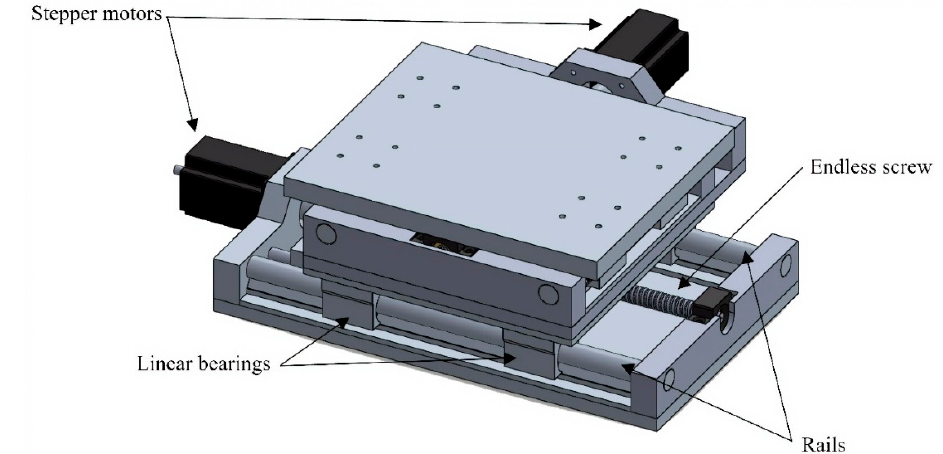
Figure 3. Schematic diagram of the motion system.